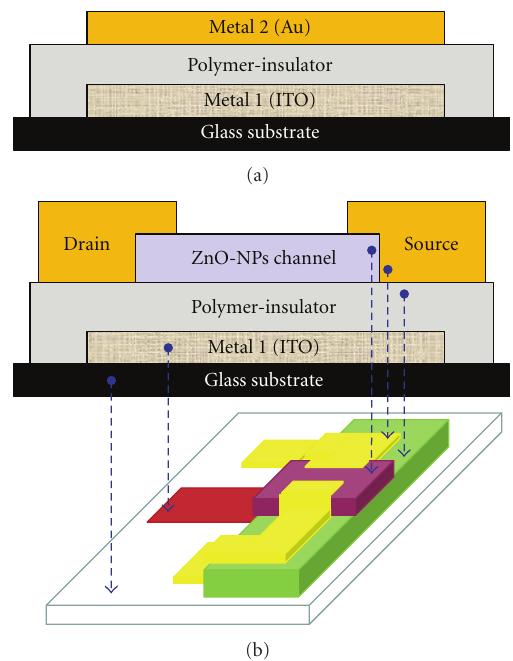
Figure 1: (a) Sandwich structure (MIM) of PVP gate dielectric insulator. (b) Configuration of “bottom-gate” and “top-contact” structure of a ZnO-NPs TFT with the polymer gate